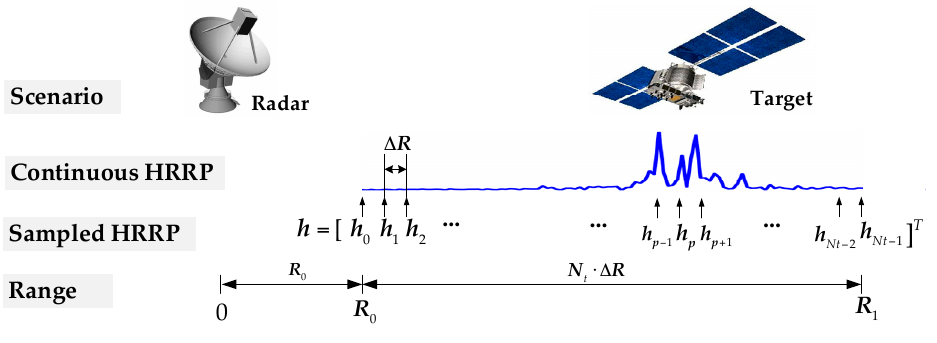
Figure 1. An illustration of the radar/target signal model.